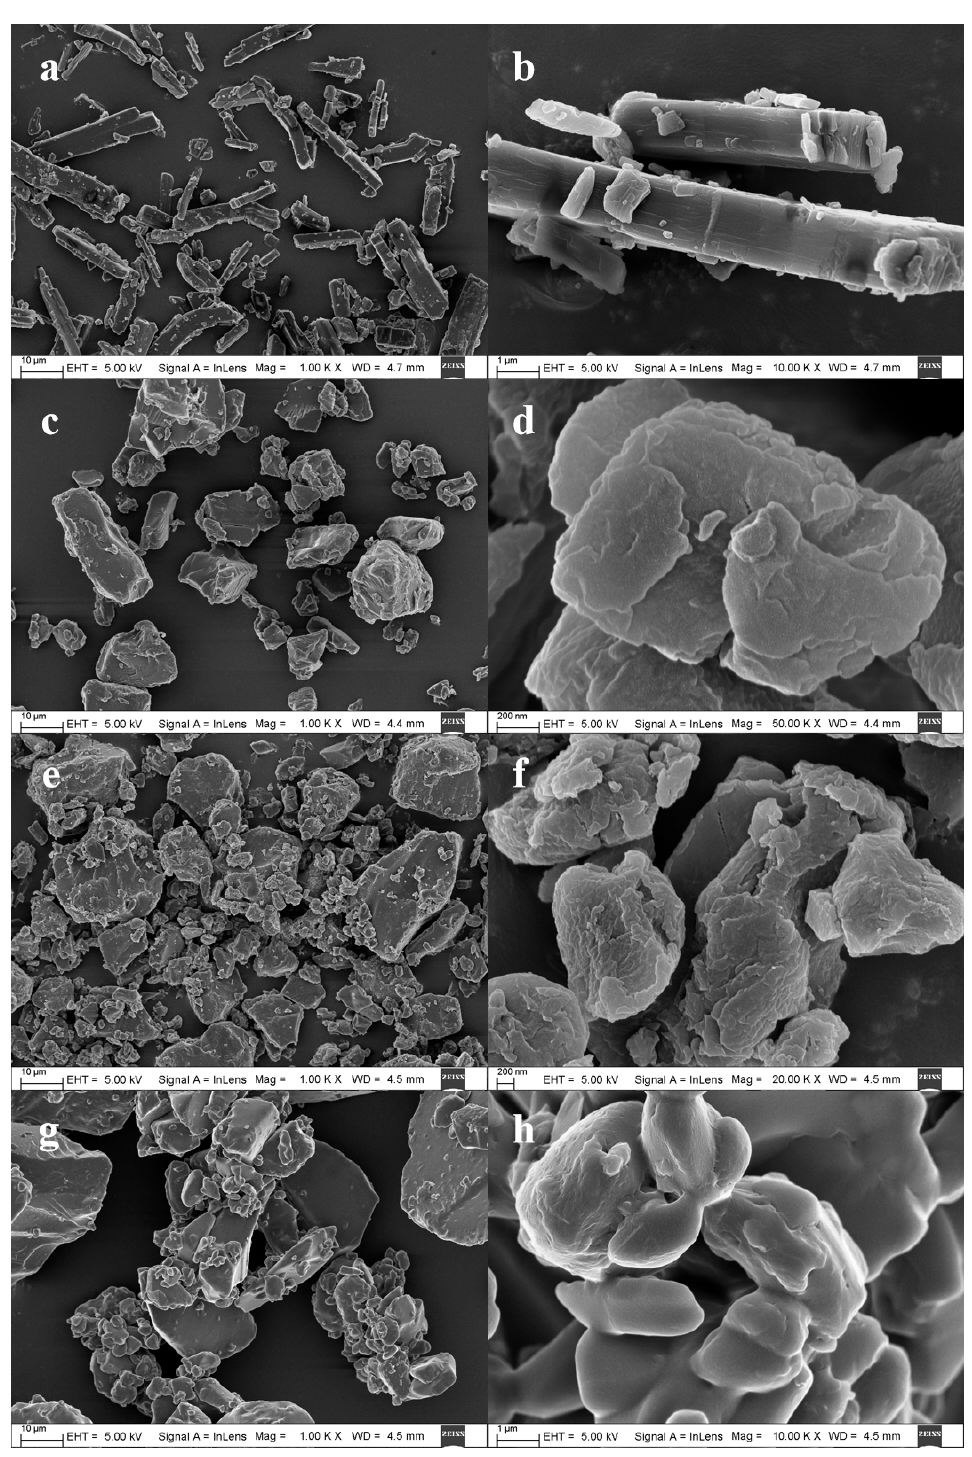
Figure 4. Representative SEM images of ( a , b ) GA, ( c , d ) BSD, ( e , f ) LA-TSD, and ( g , h ) MG-TSD.